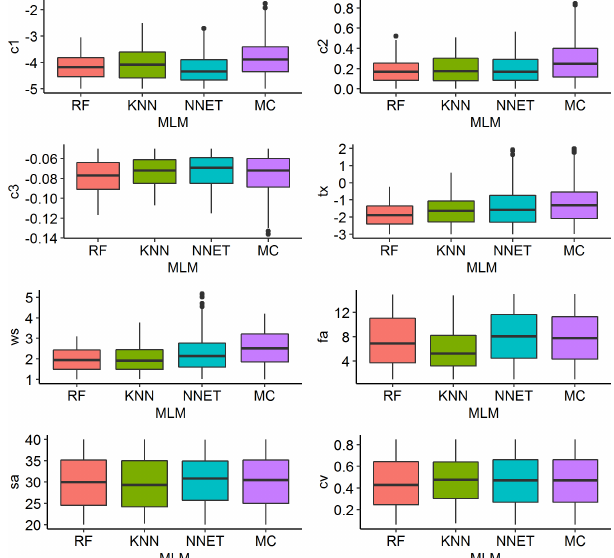
Figure 6. Posterior distribution plots of model parameters identi- fied using the coupled MLMs and MC simulation (RF, KNN, and NNET) and those directly identified from the MC simulation (MC).